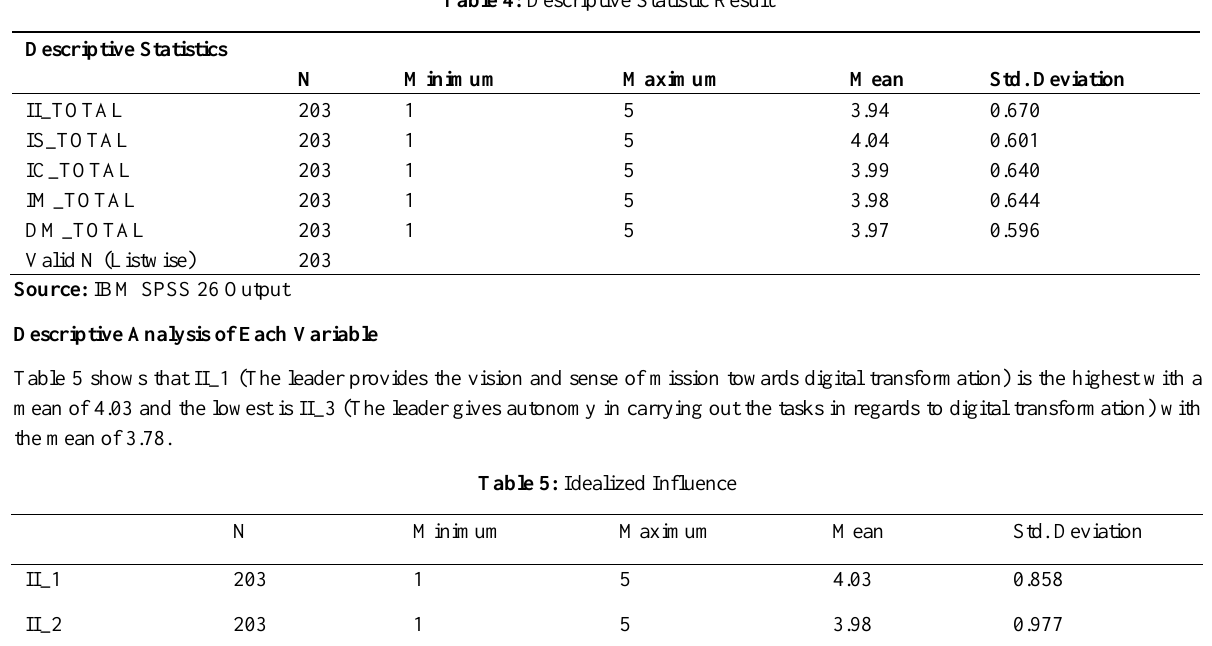
Table 4: Descriptive Statistic Result